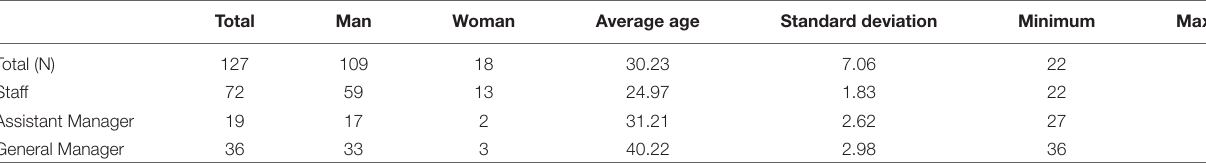
TABLE 3-1 | Descriptive statistics of participants.